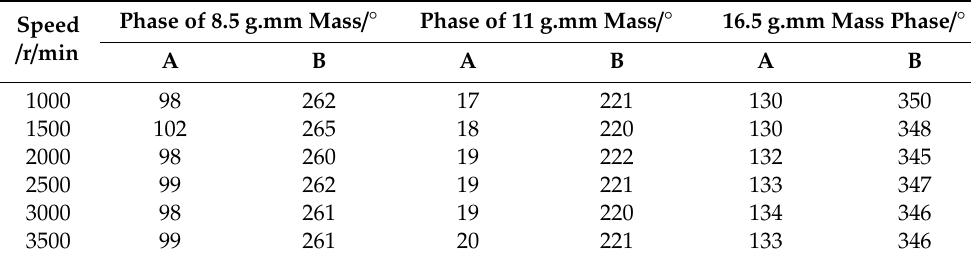
Table 1. Phase of the counterweight after optimization.